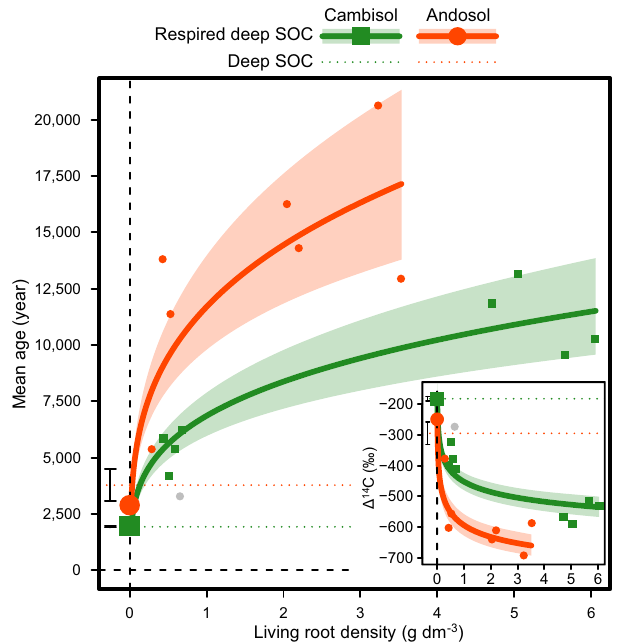
Fig. 5 | Root effects on the mean age of subsoil organic carbon respired by decomposers. Response of radiocarbon-based mean age of respired CO 2 derived fromthedecompositionofnativedeepsoilorganiccarbon(SOC)tothevariationin living root density across soil column depth at the soil core scale in the second incubation series 279 days after planting ( n =24 soil core incubations). The inset show radiocarbon signatures ( Δ 14 C) of soil-respired CO 2 used to determine the mean age of respired native SOC. Since turnover time and mean age are identical under our model assumption of SOC being a homogeneous one-pool reservoir at steady-state, the mean ages were estimated using the same modelling approach used for turnover time as described in the methods section. Symbols with error bars along the vertical dashed line show treatment means±standard errors of unplanted controls ( n =4 soil core incubations). Horizontal dotted lines with error bars show the means±standard errors of mean ages (turnover times) and radio- carbon signatures of initial deep SOC. Polygons around regression lines represent 95% con fi dence intervals. The grey symbol is an outlier not included in regression model. Statistical results are shown in Supplementary Table